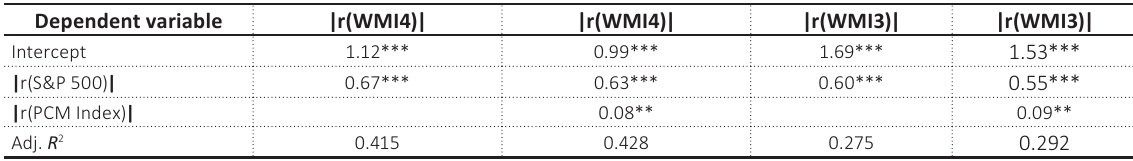
Table 2. Volatility of waste management firm stock prices and PCM